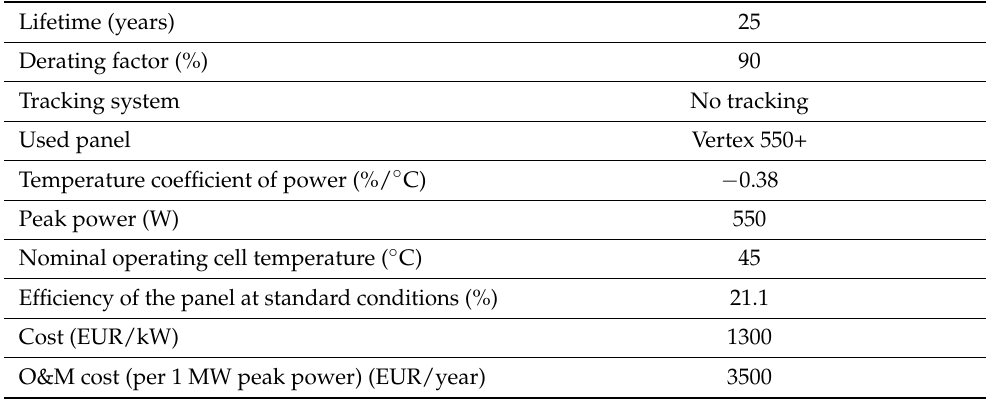
Table 3. Inputs used for the PV system